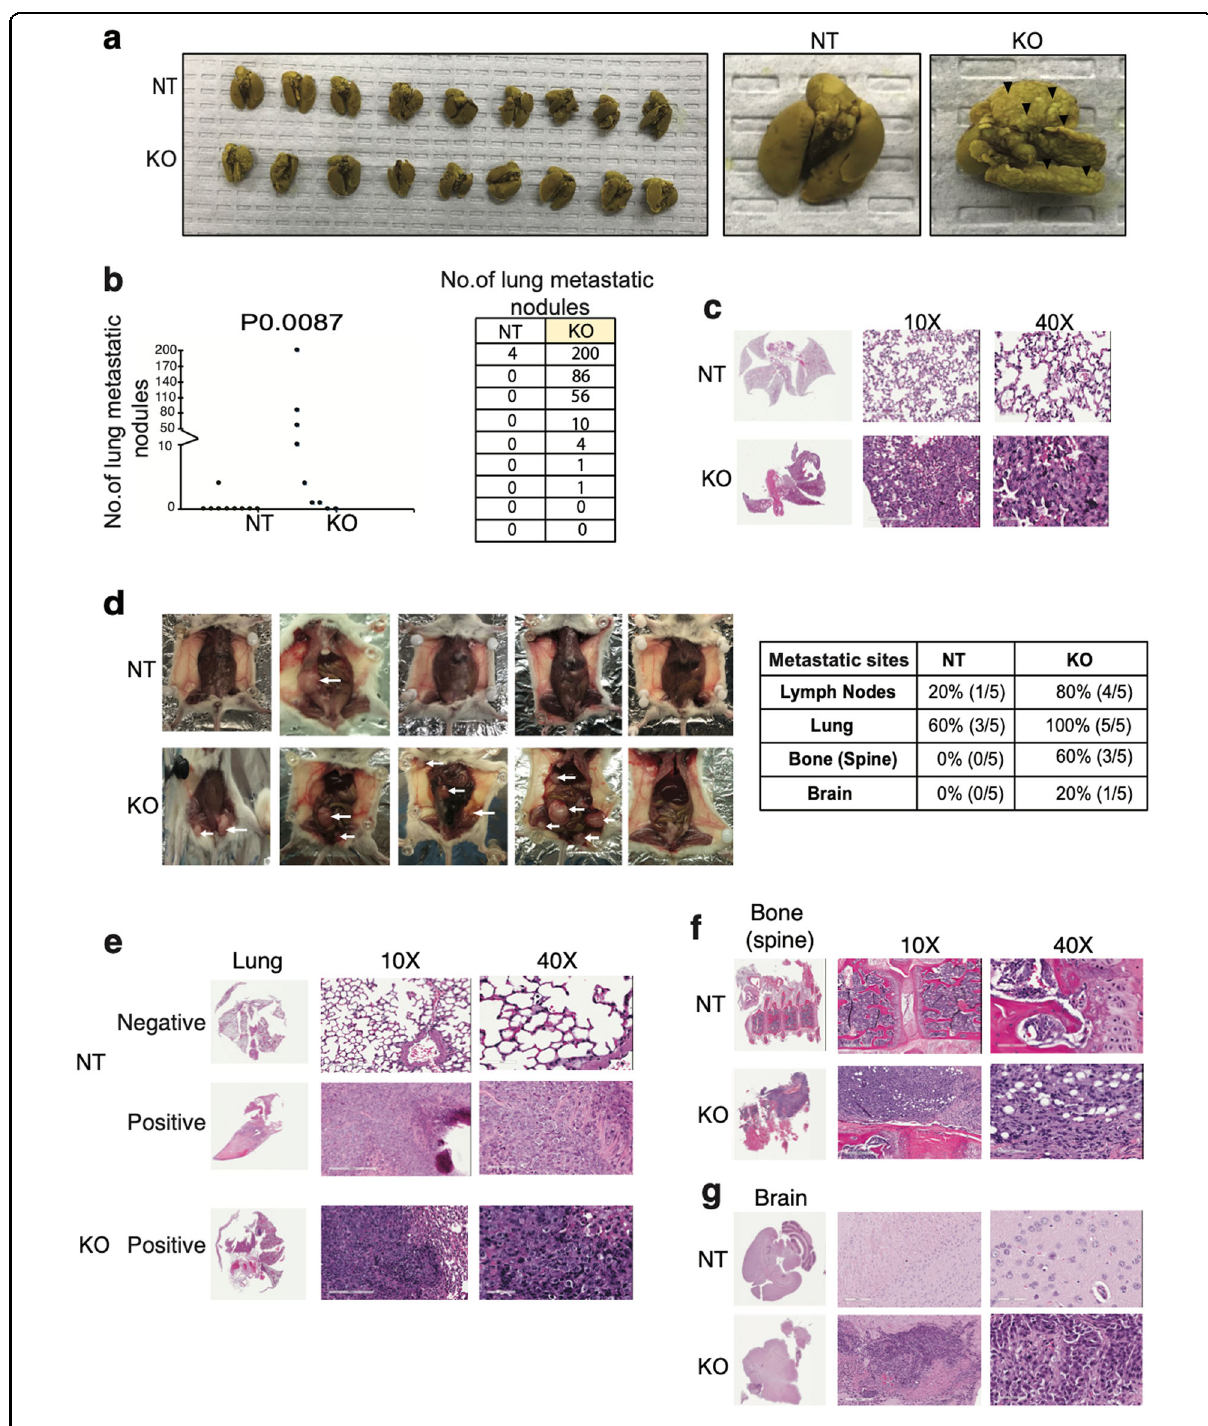
Fig. 7 Breast cancer cells show high metastatic capacity upon loss of PRLR expression in preclinical mouse models. a Photos of lungs of NSG tail vein mouse models of MCF-7/NT and MCF-7/PRLRKO (left panel) and black arrow heads indicate macro-metastases present on representative lungs (right panel). b Quanti fi cation of lung nodules in MCF-7/NT and MCF-7/PRLRKO tail vein mouse models, ** P 0.0078 (Student ’ s t -test). c Representative images of H&E staining of lung nodules of MCF-7/NT and MCF-7/PRLRKO tail vein mouse models (×10, ×40). d Left panel, photos of SKBR-3/NT and SKBR-3/PRLRKO NOD-SCID tail vein mouse models. White arrow heads indicate macro-metastases. Right panel, tabulation of the organs involved in extrapulmonary spread in SKBR-3/NT and SKBR-3/PRLRKO tail vein mouse models. e – g Representative images of H&E staining of lungs, bones, and brain metastases of SKBR-3/NT (left panel) and SKBR-3/PRLRKO (right panel) tail vein mouse models (×10, ×40).